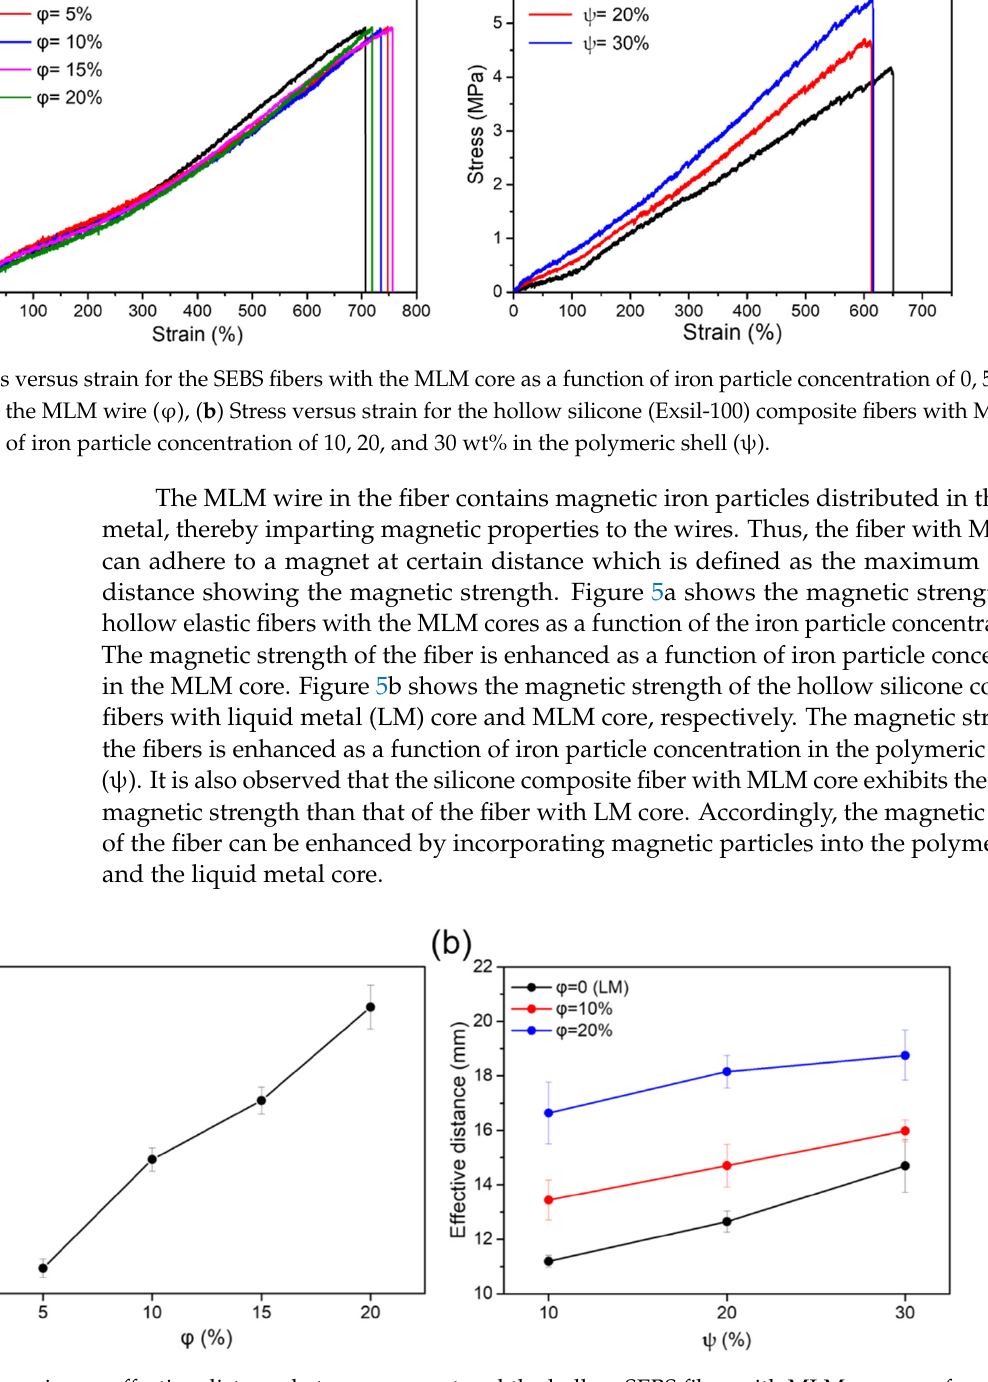
Figure 5. ( a ) The maximum effective distance between magnet and the hollow SEBS fiber with MLM core as a function of iron particle concentration of 5, 10, 15, and 20 wt% in the MLM core ( φ ). ( b ) The maximum effective distance between magnet and the hollow silicone composite fiber with the liquid metal (LM) core and MLM core as a function of iron particle concentration of 10, and 20 wt% in the MLM core ( φ ) and 10, 20, and 30 wt% in the polymeric shell ( ψ ).